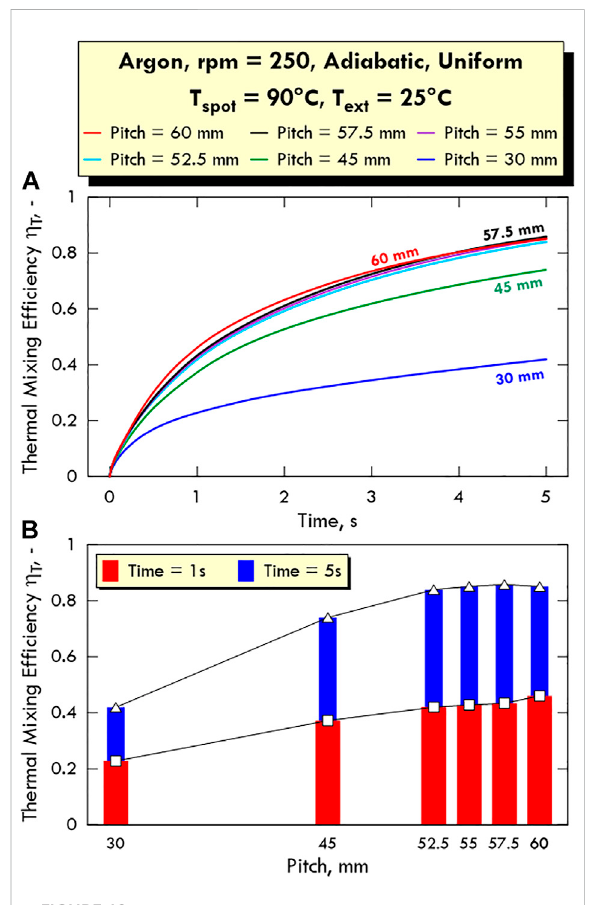
FIGURE 12 Thermal mixing ef fi ciency η T (A) as a function of time for differentvalues ofpitch and (B) as afunction of pitch at 1 and 5 sin adiabatic conditions in uniform con fi guration. Fluid: argon, T spot = 90 ° C, T ext = 25 ° C.